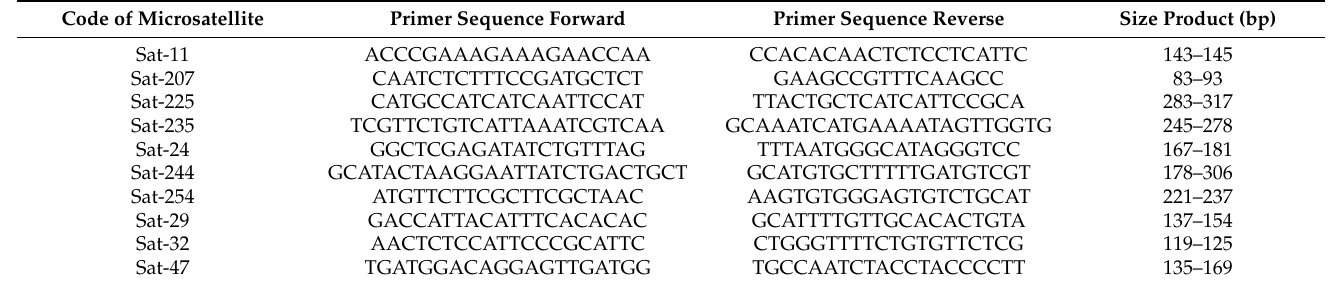
Table 2. List of microsatellite markers with their locus code, primer sequences and product size. Code of